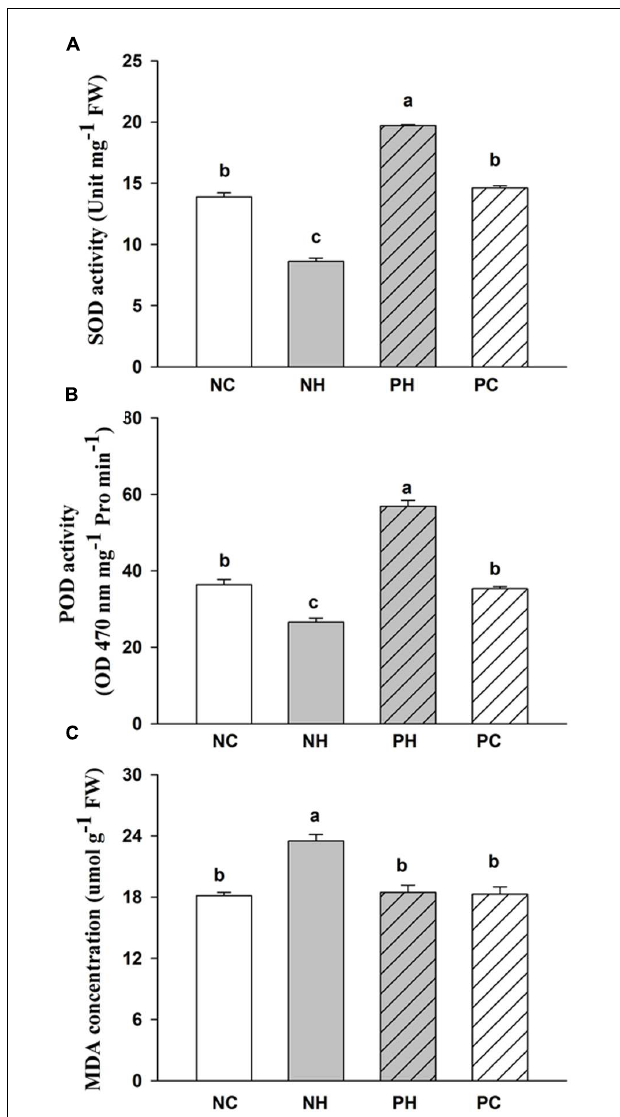
FIGURE 1 | Progeny of heat primed plants are more tolerant to high-temperature stress applied during grain filling than that of non-primed plants as exemplified by up-regulated activities of antioxidant enzymes. (A) SOD; (B) POD; (C) MDA; NC, progeny of non-primed plants without post-anthesis high temperature stress; NH, progeny of non-primed plants with post-anthesis high temperature stress; PC, progeny of primed plants without post-anthesis high temperature stress; and PH, progeny of primed plants with post-anthesis high temperature